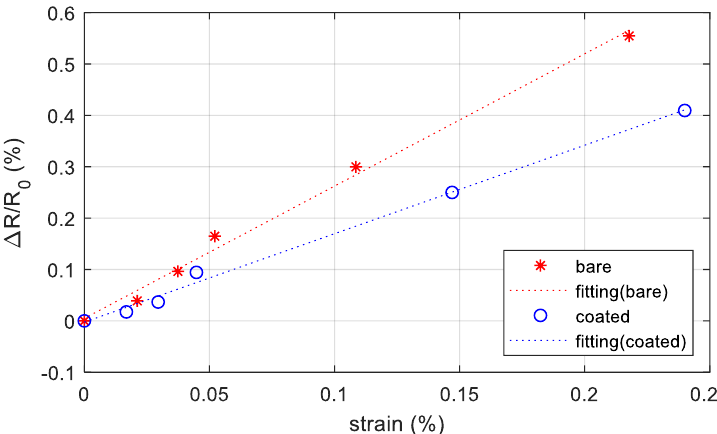
Figure 11. Resistance change with respect to the starting resistance (no external loads) versus the measured strain in the area including the sensor without protection (bare) and with protective layer (coated). The points are the measurements data, while the dotted line is the best-fit line using the least square method.